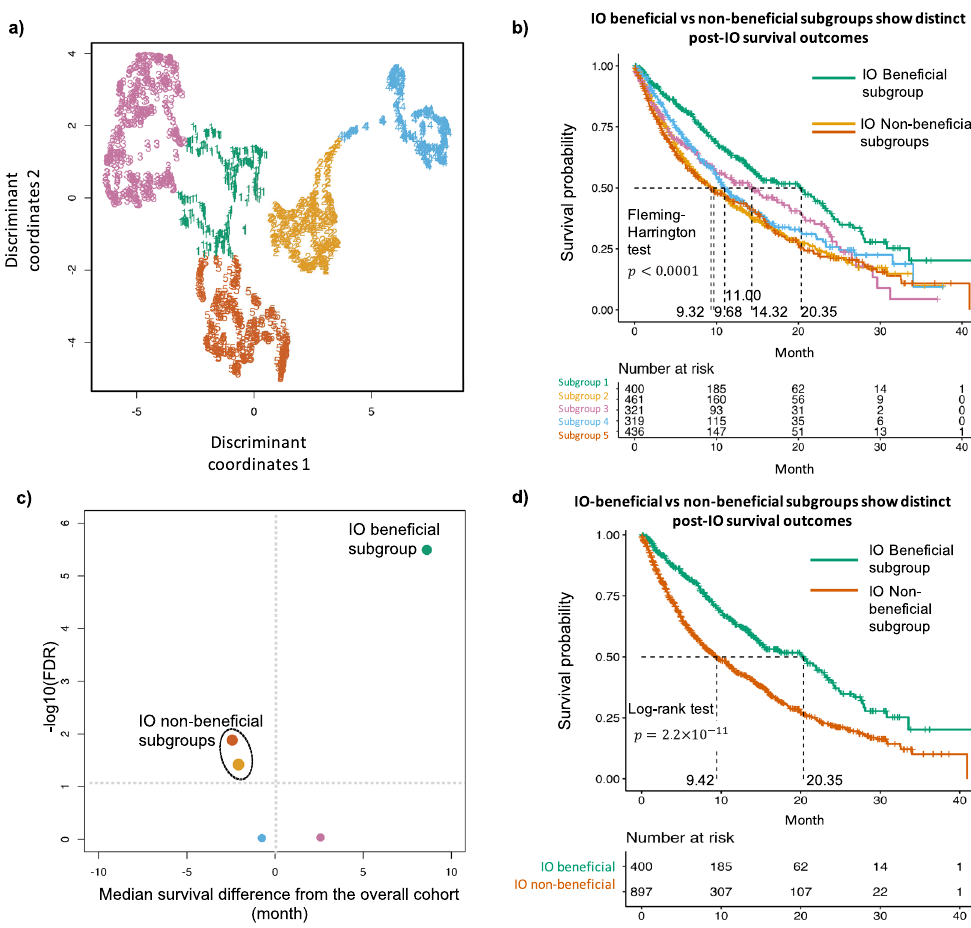
Fig. 2 Clinico-genomic “ DeePaN ” framework discovered NSCLC subgroups with distinct overall survival outcomes of post-IO treatment. a Five distinct patient subgroups were discovered by DeePaN, visualized by the 2D UMAP projection of the deep patient graph representation in the latent space. Each data point denotes a patient and colors denote distinct subgroup memberships. b The fi ve subgroups discovered by DeePaN showed overall signi fi cant post-IO survival difference by the Kaplan – Meier survival plots (same subgroup color encoding as in a ). c Using the overall cohort (1937 patients) as the control, comparison of survival of each subgroup with the overall cohort identi fi ed distinct IO bene fi cial and IO non-bene fi cial subgroups, demonstrated by a volcano plot (see “ Methods ” ). Each bubble represents a patient subgroup, same subgroup color encoding was used as in a and b , and bubble sizes are proportional to corresponding subgroup patient counts. The x axis represents the difference of the estimated median survival times between a subgroup and the overall cohort. The vertical line marked zero median survival difference, with bubbles on the right of the vertical line showing the tendency of bene fi cial IO outcomes and bubbles on the left showing the tendency of IO non-bene fi cial outcomes. y axis is the − (FDR) of the corresponding log-rank test between a subgroup vs. the overall cohort with multiple-comparison adjustment by Benjamini – Hochberg procedure, representing the statistical signi fi cance of the observed survival difference. The horizontal dashed line marked the statistical signi fi cance cutoff of FDR of 0.05. Two IO non-bene fi cial subgroups (red and orange) and one IO bene fi cial subgroup (green) were identi fi ed with signi fi cantly different post-IO overall survival from the overall cohort. We combined the two IO non-bene fi cial subgroups (red and orange) into one subgroup since they have similar